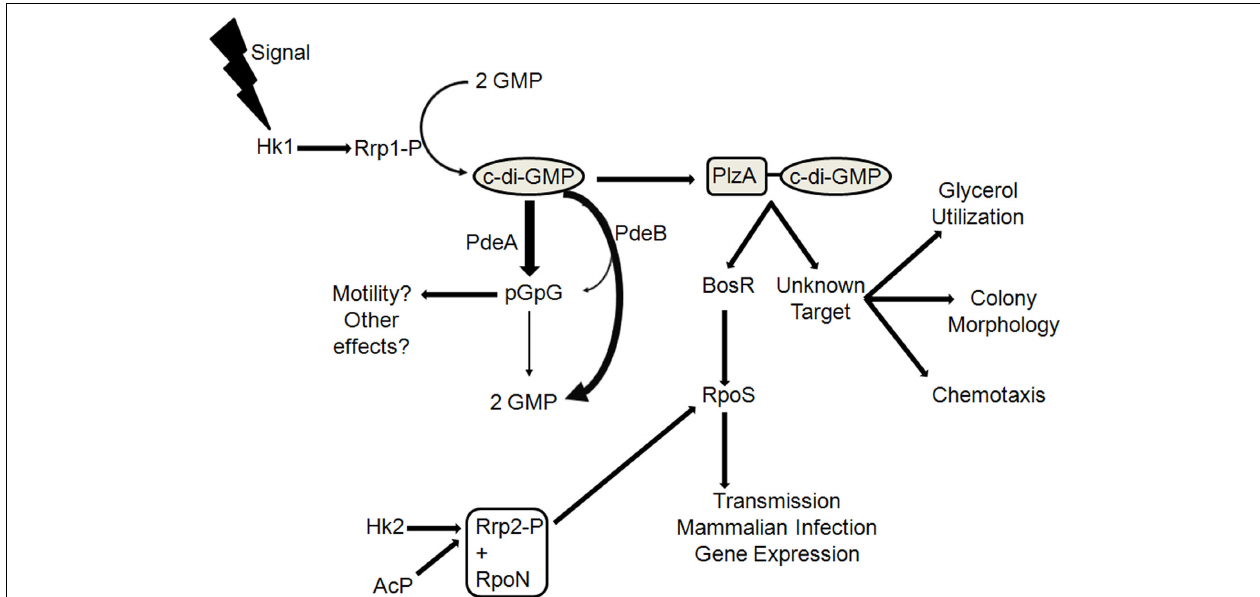
FIGURE 1 | A simplified working model of the c-di-GMP signaling pathway in B. burgdorferi . Hk1 and Rrp1 are present in the same operon and are thought to comprise a TCS. The diguanylate cyclase activity of Rrp1 is dependent upon its phosphorylation state, which presumably occurs in the cell by its cognate sensor kinase, Hk1. PlzA, a c-di-GMP-binding protein, is hypothesized to affect multiple virulence characteristics in B. burgdorferi . PlzA has been shown to positively regulate BosR protein levels, which regulates rpoS expression. RpoS, in turn, induces expression of genes, such as ospC , which are known to be important for mammalian infection as well as for genes involved in chitobiose utilization, which was shown to be important for colonization in the tick. rpoS expression is also governed by the Hk2-Rrp2 TCS; thus, PlzA serves as the connector between both TCS in B. burgdorferi .